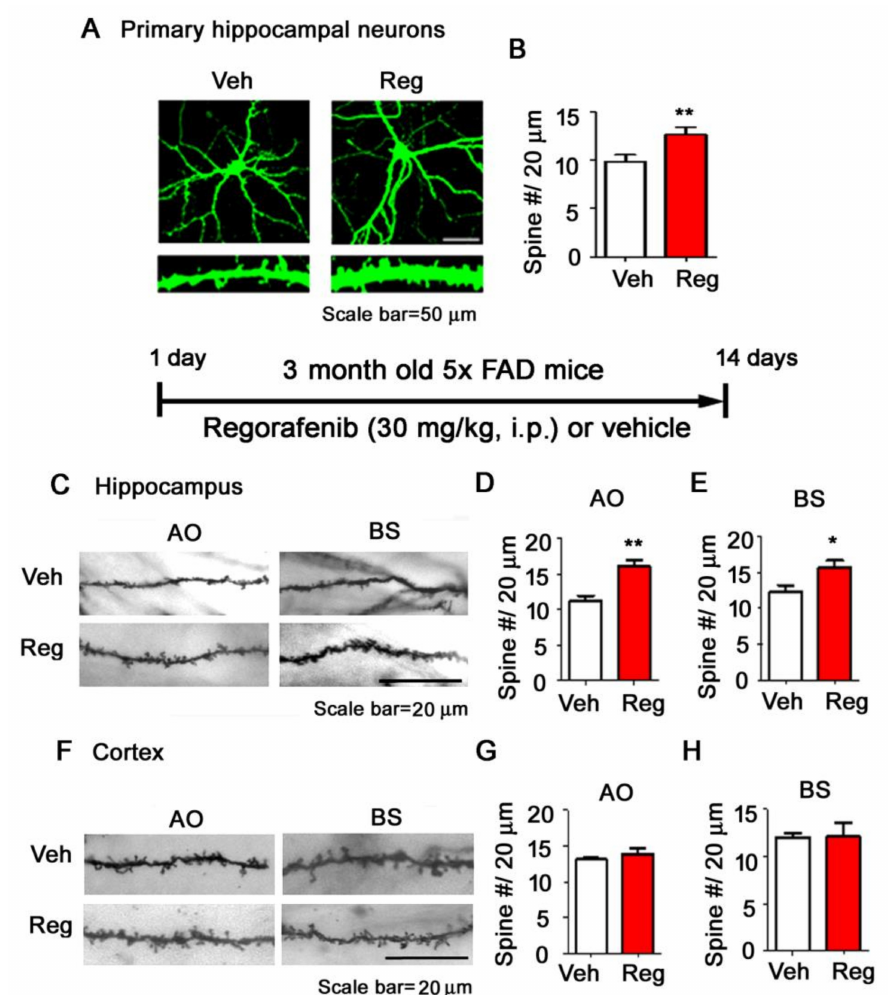
Figure 6. Regorafenib promotes dendritic spine formation in primary hippocampal neurons and in the brains of 5x FAD mice. ( A – B ) Primary hippocampal neurons were transfected with GFP and treated with regorafenib (5 µ M) or vehicle (1% DMSO) for 24 h before measuring dendritic spine density (Veh, n = 20; regorafenib, n = 21). ( C – H ) 5x FAD mice were injected with regorafenib (30 mg / kg, i.p.) or vehicle (2% DMSO + 30 % PEG + 5 % Tween 80) daily for two weeks, and Golgi staining was conducted in the hippocampus CA1 and cortical layer V (n = 4 mice / group). * p < 0.05, ** p <